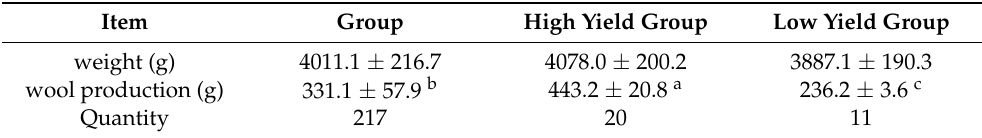
Figure 1. Histograms showing the ( A ) weight and ( B ) wool production data of Angora rabbits. Table 2. Weight and wool production data of high- and low-yield groups.